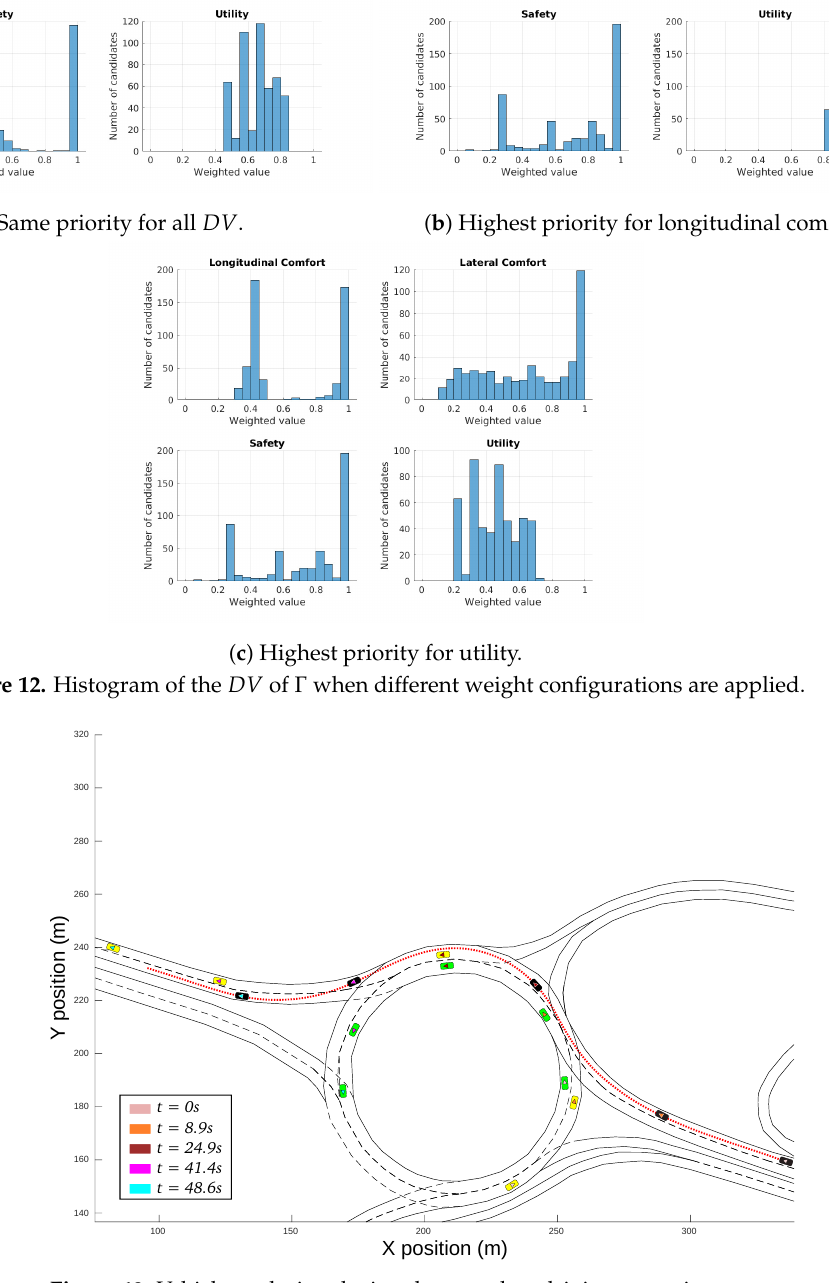
Figure 13. Vehicle evolution during the complete driving